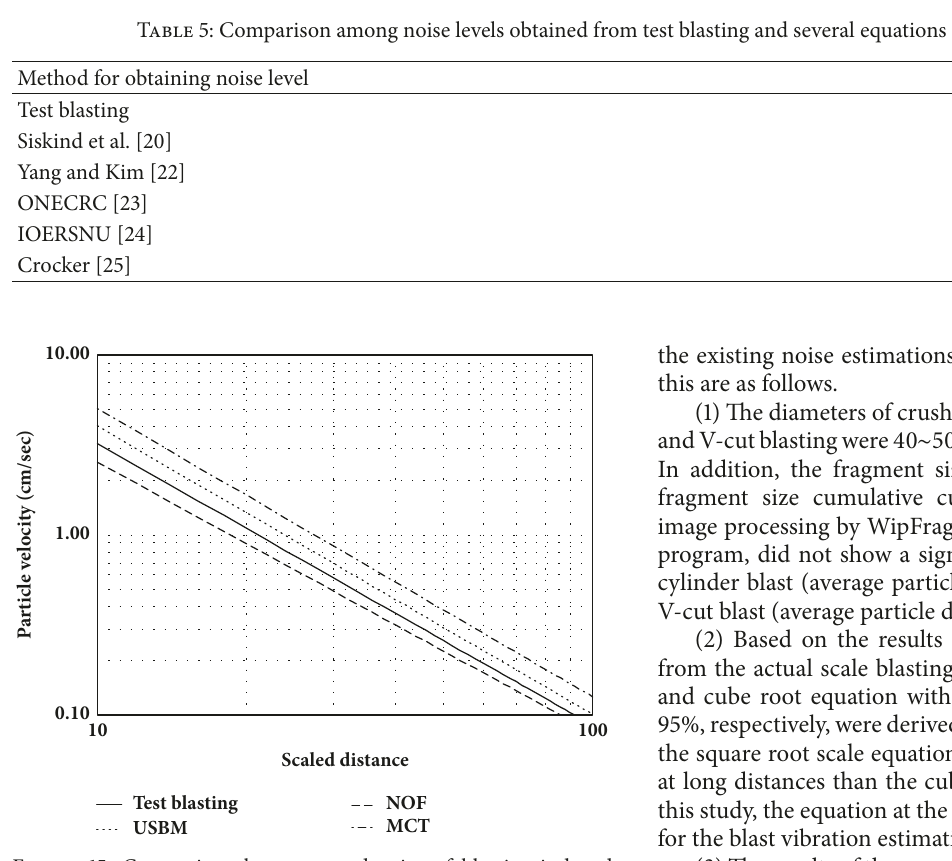
Figure 15: Comparison between tendencies of blasting-induced vibration with